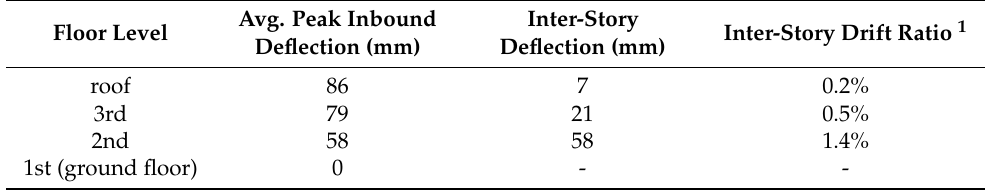
Table 5. Test 2—Average of peak inbound lateral deflections and estimated inter-story drift